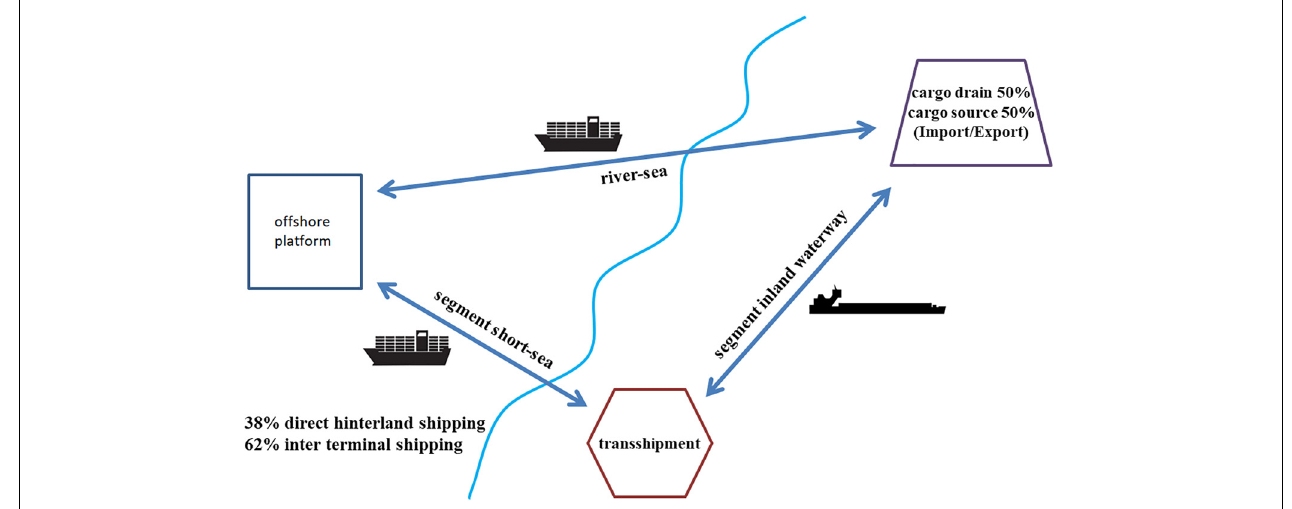
FIGURE 2 | An example that presents the considered connection